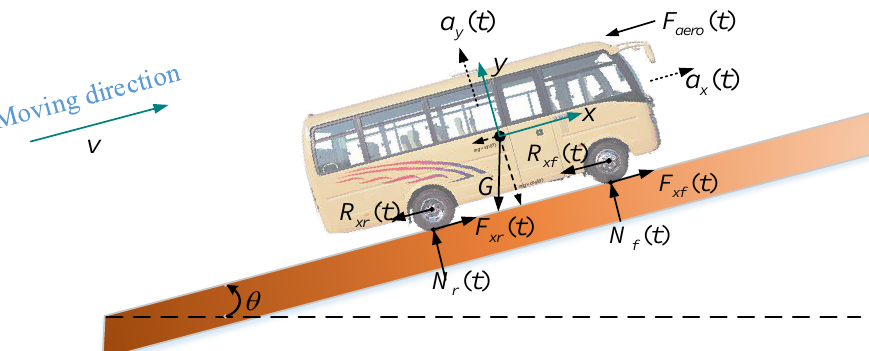
Figure 2. Forces analysis of a vehicle moving on an inclined road.